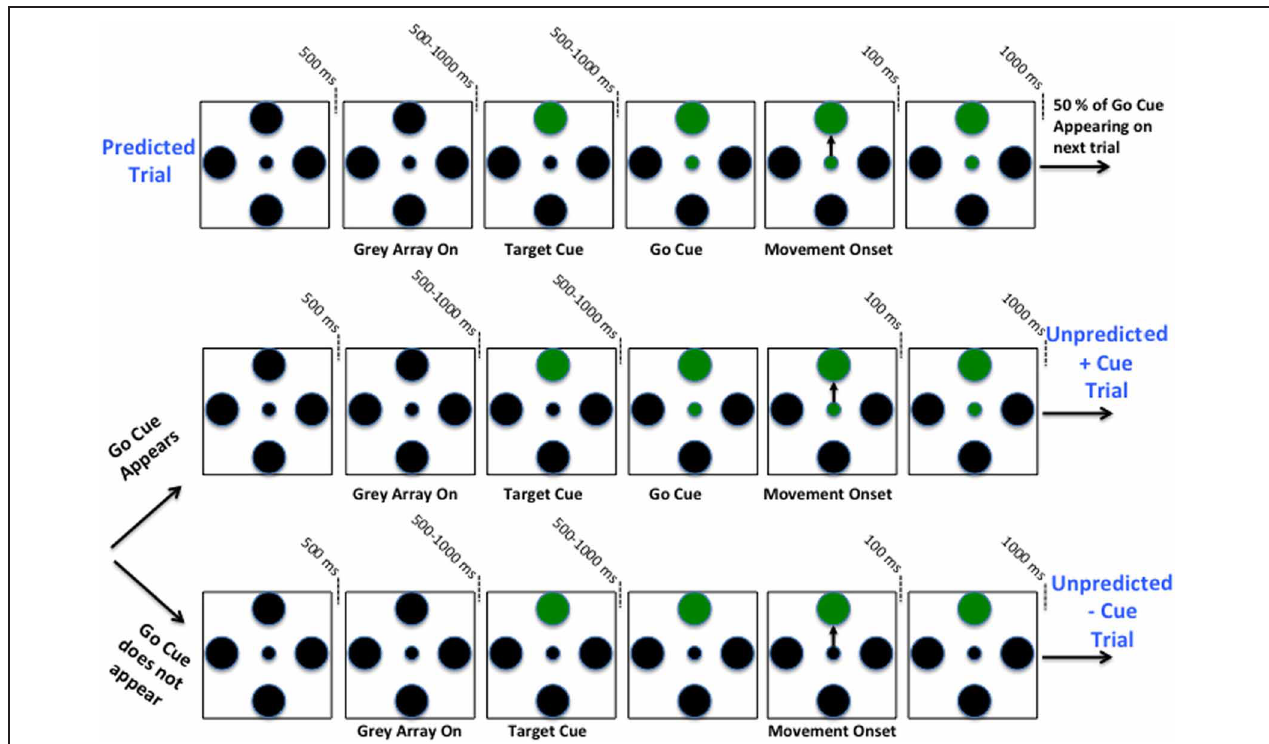
FIGURE 1 | Schematic of two-step sequential motor task. Predicted + Cue trial (Top), Unpredicted + Cue trial (middle), Unpredicted − Cue trial (bottom).